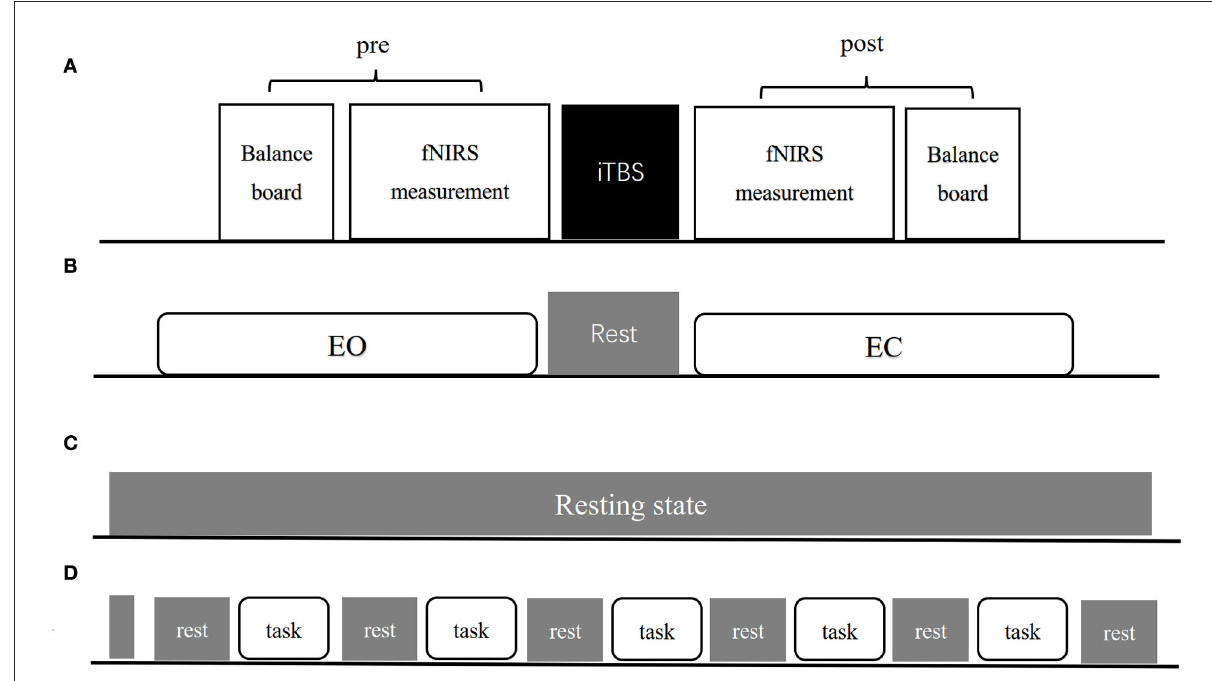
FIGURE1 The experimental procedure (A) includes pre-measurement, iTBS intervention and post-measurement three parts. (B–D) Show exact procedures of pre and post measurement. (B) Indicates 1-min EO and EC standing balance measurement separated by 1-min rest. (C) Indicates resting-state fNIRS measurement lasting for 8-min. (D) Indicates balance task fNIRS measurement organization both in EO and EC